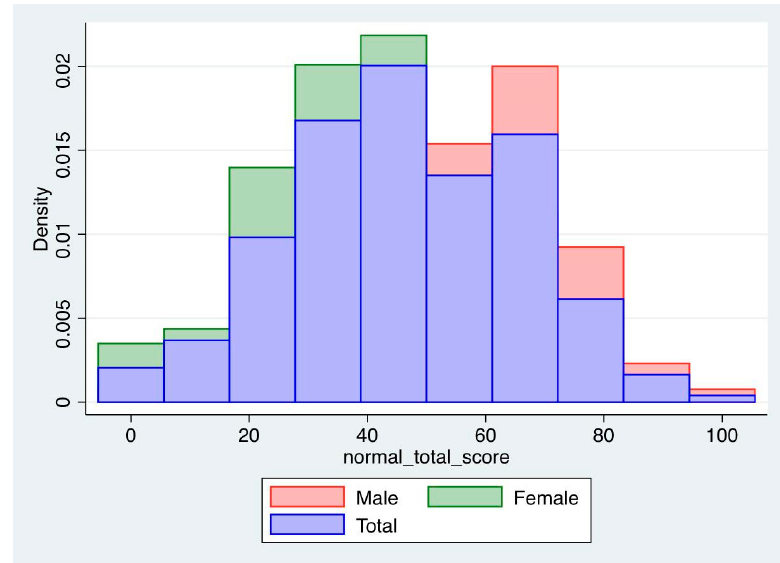
Figure 1. Total score